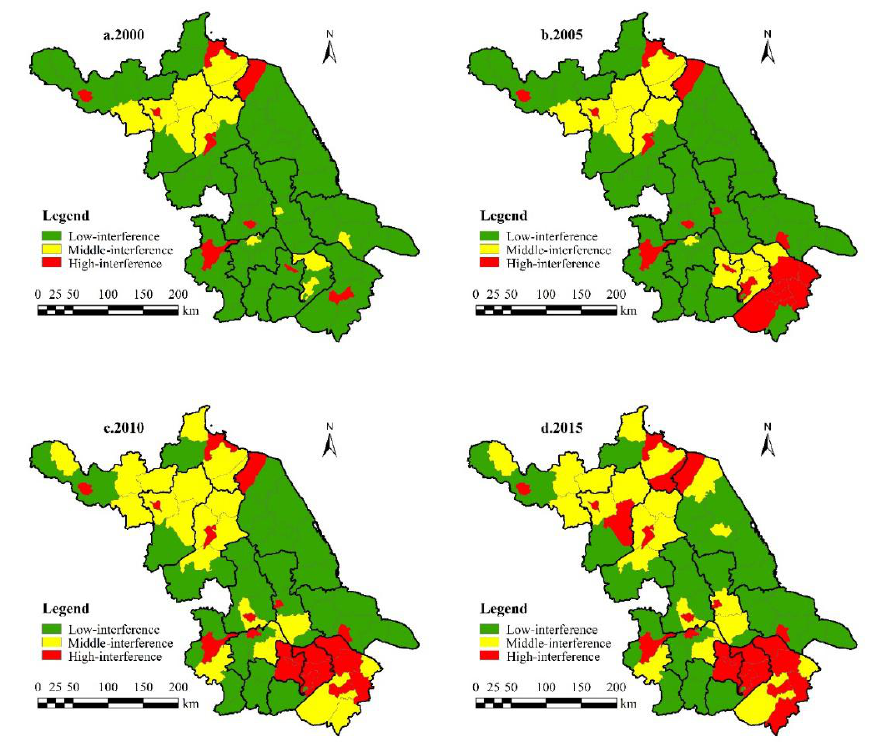
Figure 5. Spatial distribution of land human interference index ( LHAI) in 2000, 2005, 2010, and 2015. Overall, from 2000 to 2015, the intensity of human interference increased in Jiangsu. Two centers of high-interference areas were formed. Northern Jiangsu was concentrated in downtown Suqian, Siyang, downtown Huaian, and Lianshui, while southern Jiangsu was concentrated in downtown Suzhou, downtown Wuxi, and downtown Nanjing. The northern region comprises important agricultural production areas. As a result, because of frequent changes in cultivated land, landscape interferences in the region continuously increased. Rural construction in northern Jiangsu was characterized by a large land area, scattered layout, and inefficient use of rural residential areas. By the end of 2004, the per capita living area of rural areas in northern Jiangsu was 201.09 m 2 , far exceeding the reasonable standard of 100 m 2 determined by the province, resulting in a high LHAI in rural residential areas. Relying on geographical and policy advantages, the development of export-oriented industries and intensive construction on limited land resources caused serious human intervention in the southern region. The results of the LHAI from 2000 to 2015 confirmed that urbanization had a serious impact on land-use change in Jiangsu. This was confirmed by many studies—for instance, a study conducted by Sun et al. [36] showed that Wuhan’s built-up areas expanded at an average rate of 4.36% during 1991–2013, resulting in a severe transformation of the living environment in urban areas. 3.2.2. Situation of Time Change As shown in Figure 6, the number of low-interference counties in the study area gradually decreased from 56 to 34 during 2000–2015. The number of middle- and high-interference counties increased gradually, and the number of high-value areas increased by 144%. Frequent land reconstruction activities led to severe artificial disturbance of the landscape.